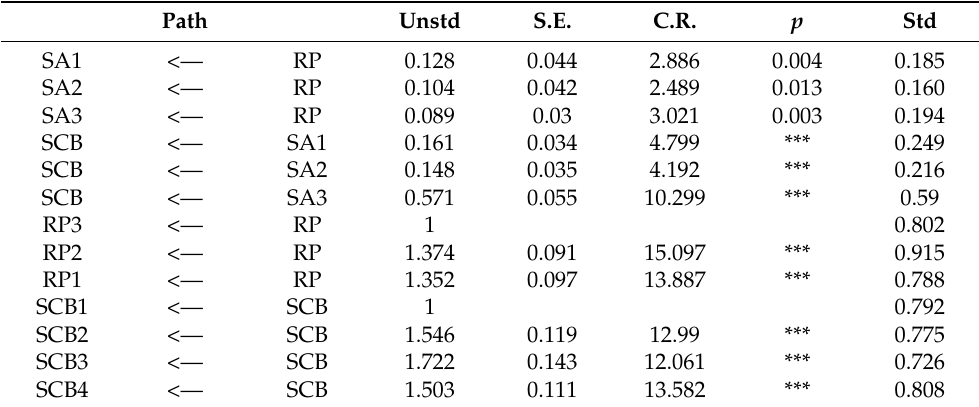
Table 11. Path coefficient and significance of